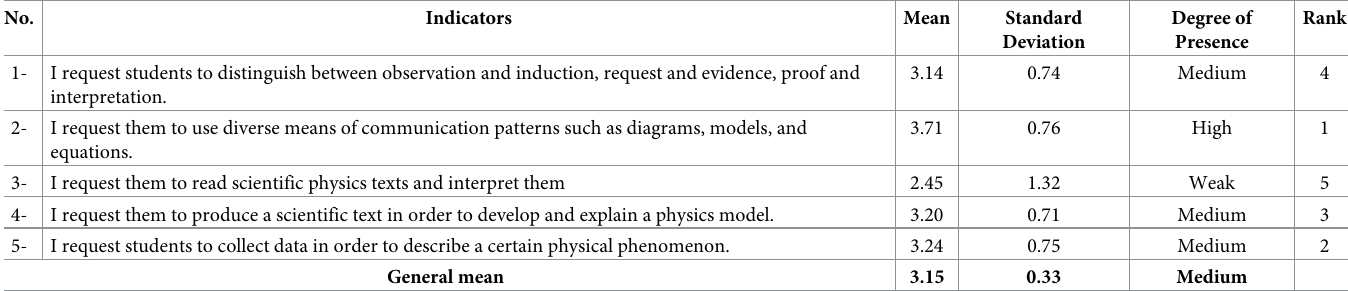
Table 9. The means and standard deviations of the presence of the “obtaining, evaluating, and communicating information” practice. No.